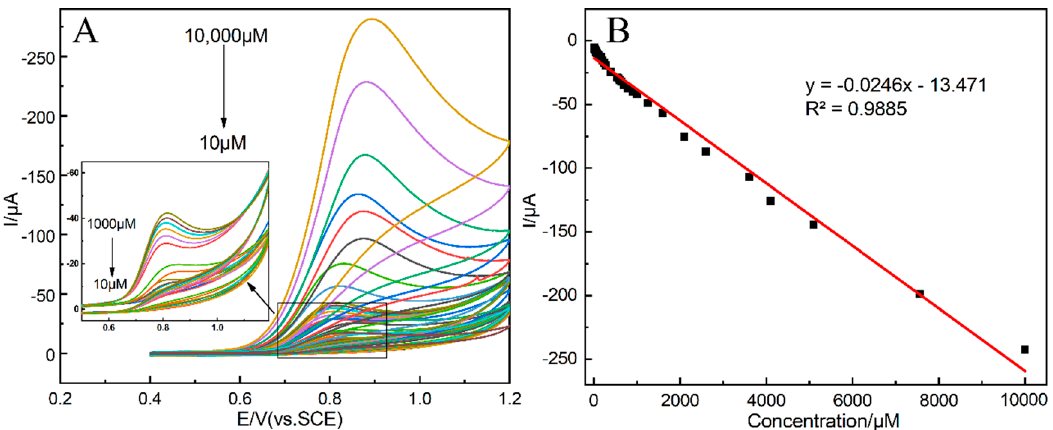
Figure 7. ( A ) CV curves of MoS 2 /MWCNT-COOH/GCE in 0.1 M PBS with nitrite in the range from 10 to 10,000 μ M; ( B ) the fitting equation of the sensor under different concentrations of nitrite.